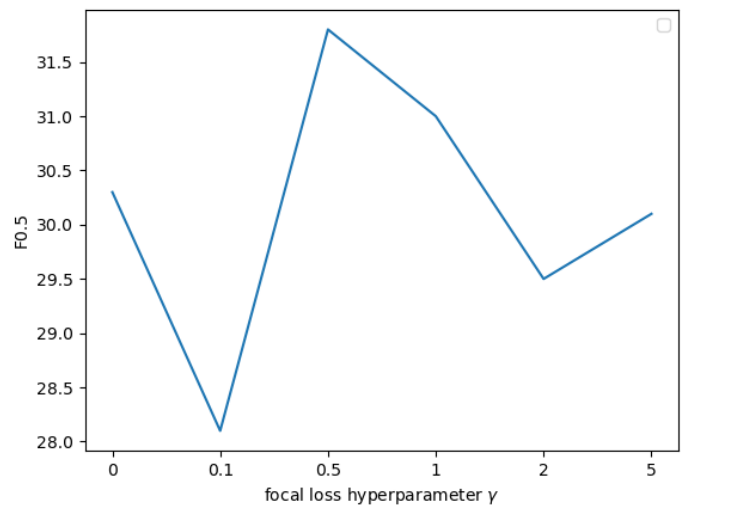
Figure 6. Tuning for focal loss hyperparameter γ for